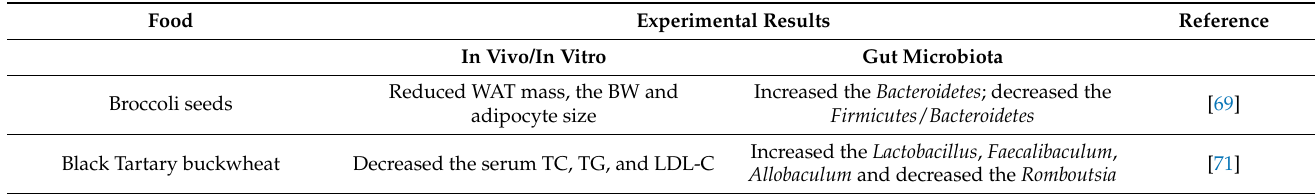
Table 4. Germinated food against obesity in vitro/in vivo based on gut